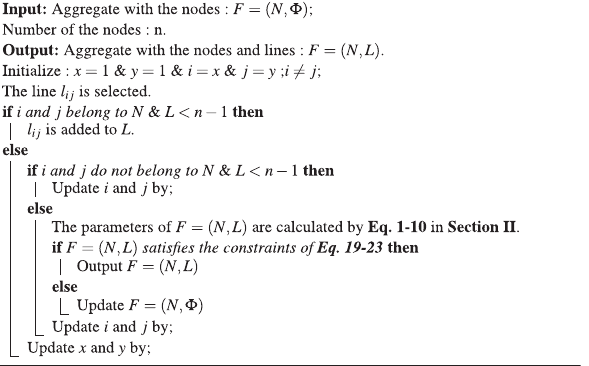
Algorithm 2: Solution algorithm of